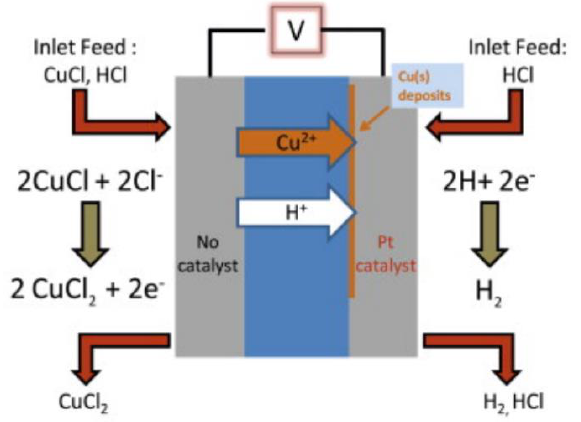
Figure 7. CuCl-HCl electrolysis schematic and chemical reactions. Reproduced with permission from [92].